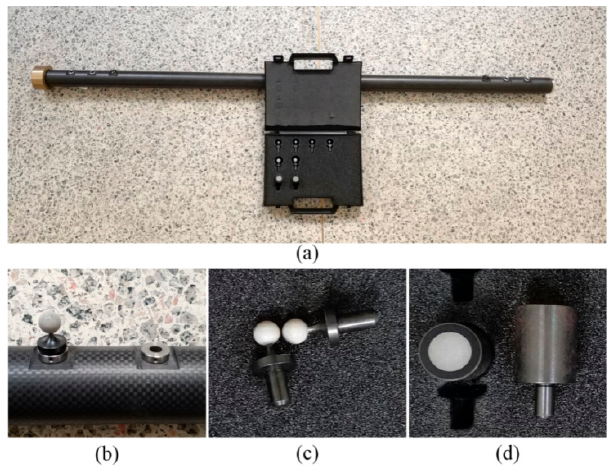
Figure 11. The carbon fiber bar and RRTs. ( a ) The scale bar; ( b ) two of the bushing holes and a target plugged in; ( c ) two spherical targets; ( d ) two planar targets.